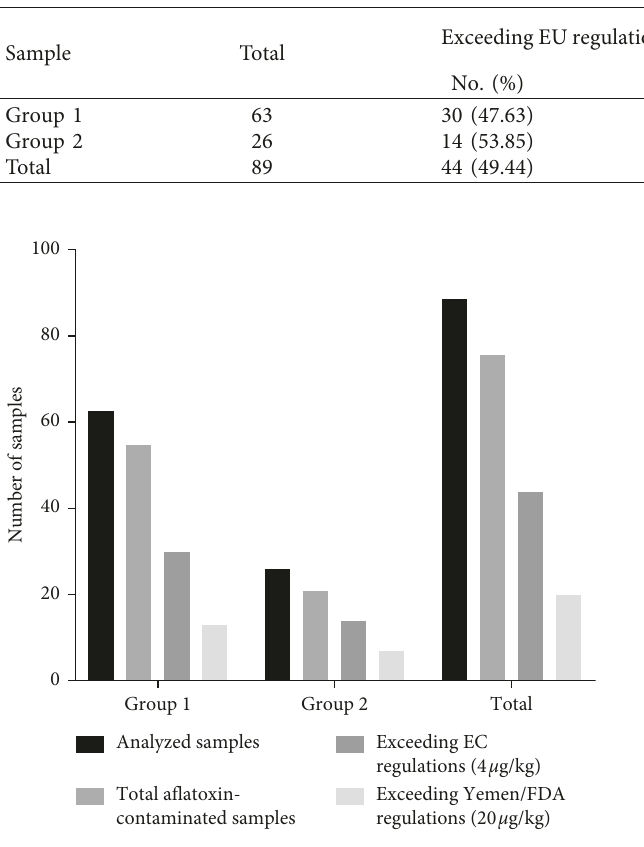
Table 5: Total aflatoxin contamination in groundnuts exceeding the EU tolerance limit (4 μ g/kg) and FDA/Yemen regulation (20 μ